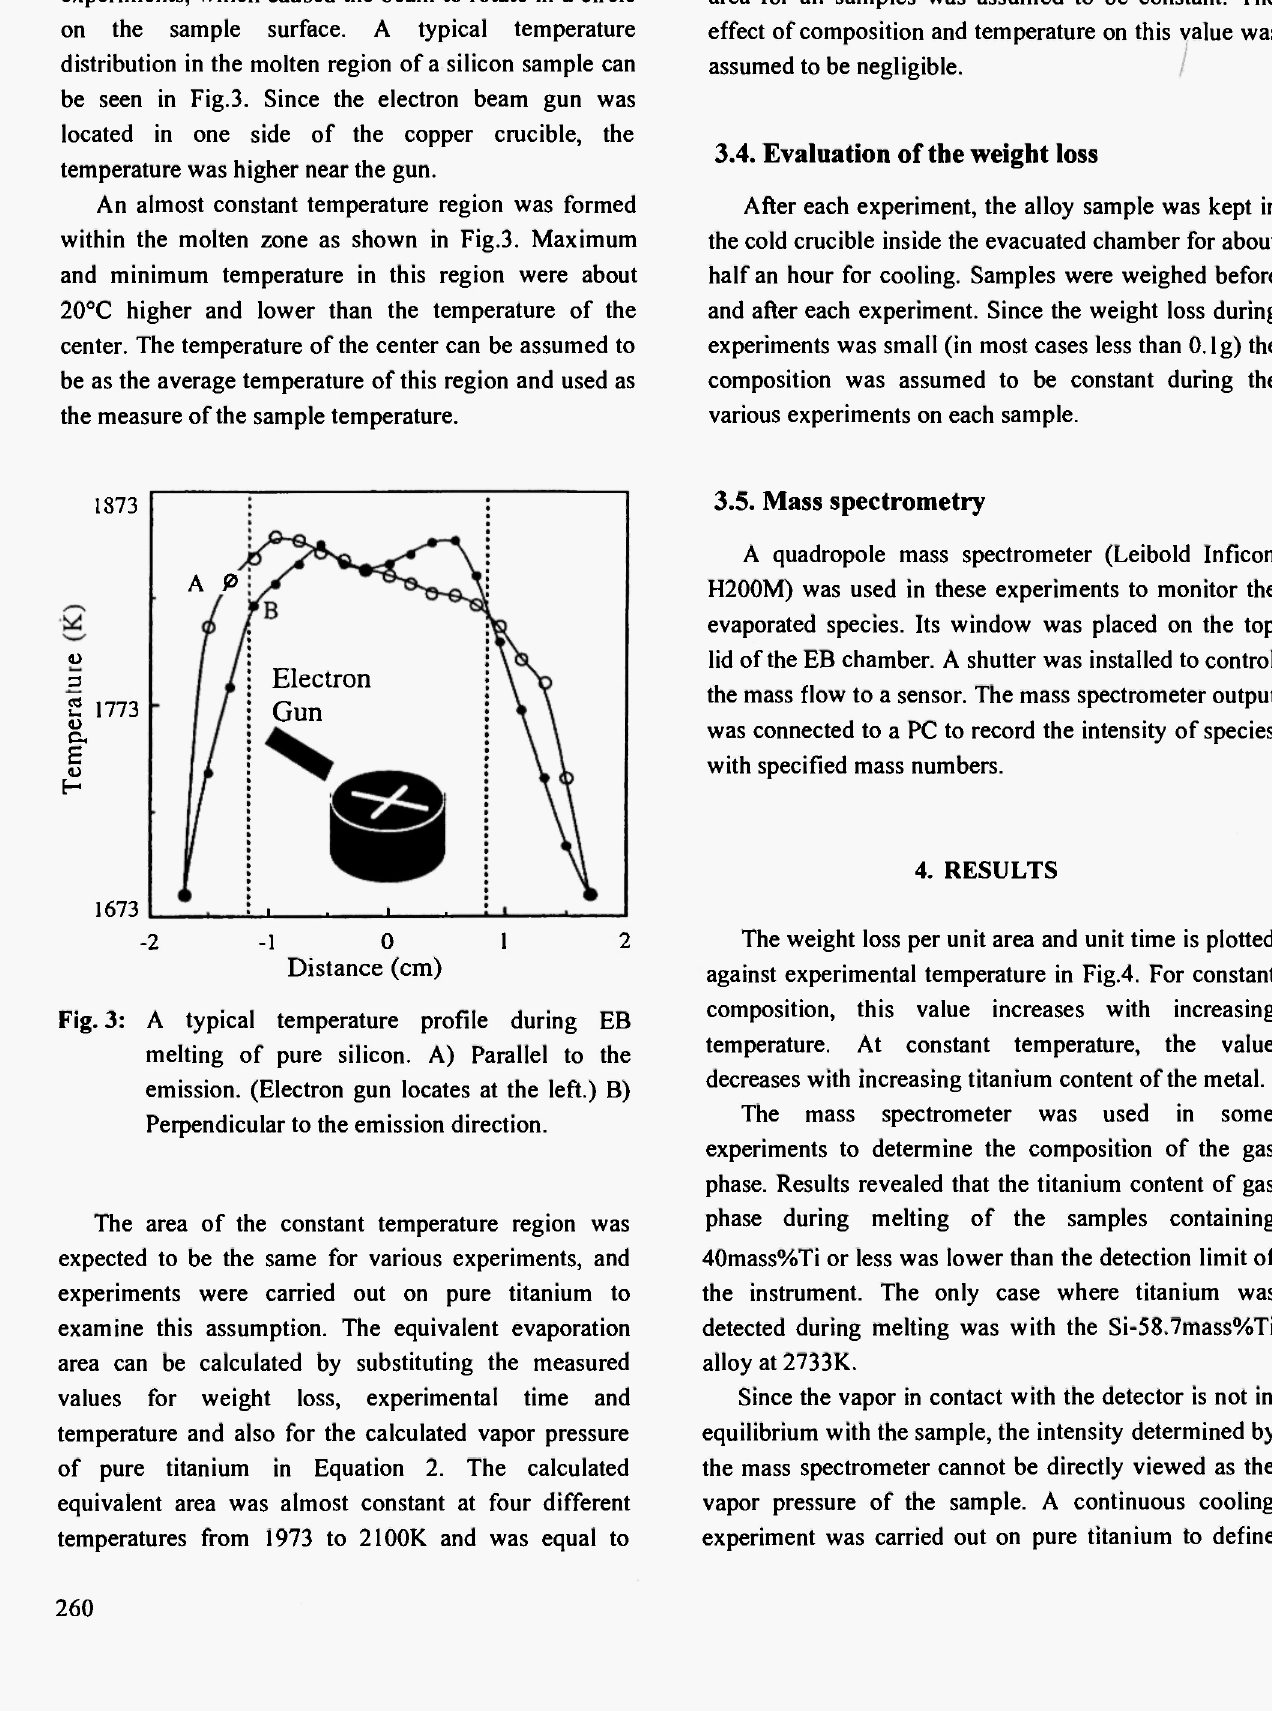
Fig. 3: A typical temperature profile during EB melting of pure silicon. A) Parallel to the emission. (Electron gun locates at the left.) B) Perpendicular to the emission